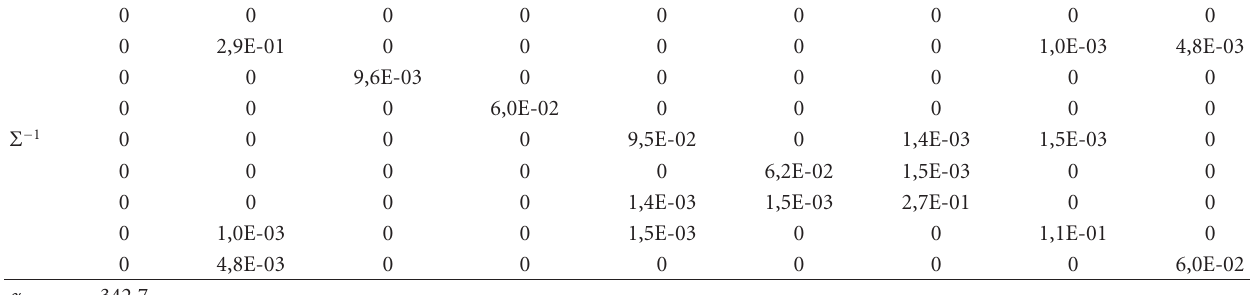
Table 2: Distance matrix Σ − 1 and α H averaged in 100 runs of ( µ , λ )-ES. Values below 1E-3 are set to zero.